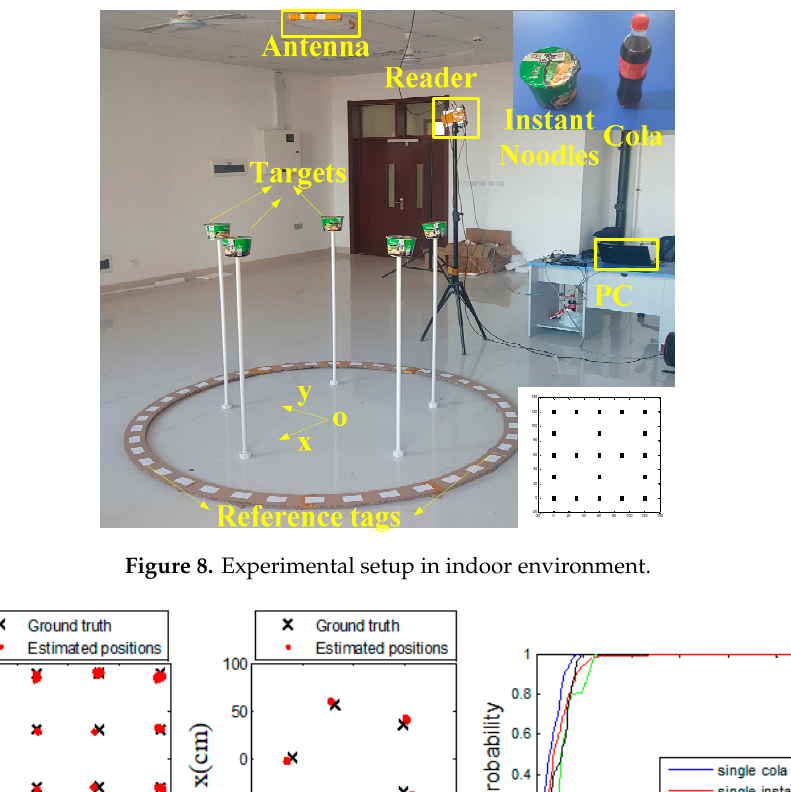
Table 1. Statistics of single target localization results.